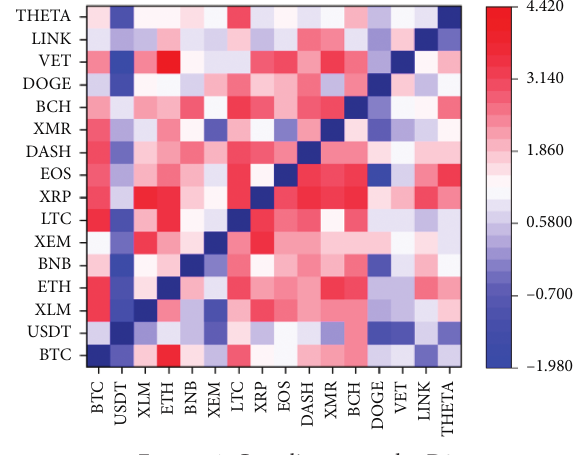
Figure 1: Causality test under Original series9 (D0).